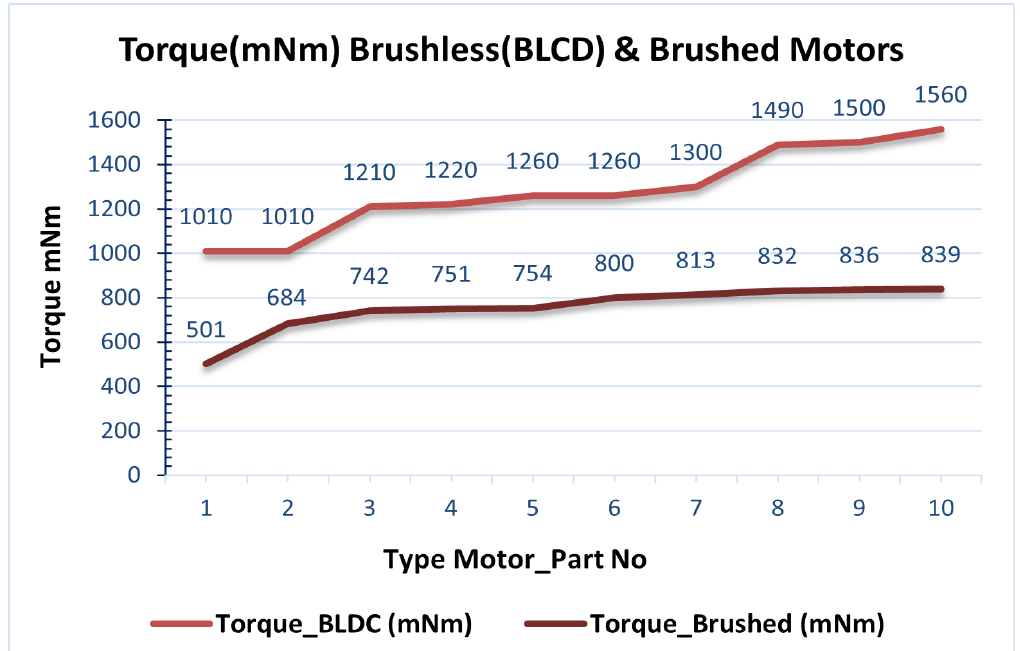
Figure 12. Comparison Torque (mNm) Brushless (BLDC) and Brushed Motor.